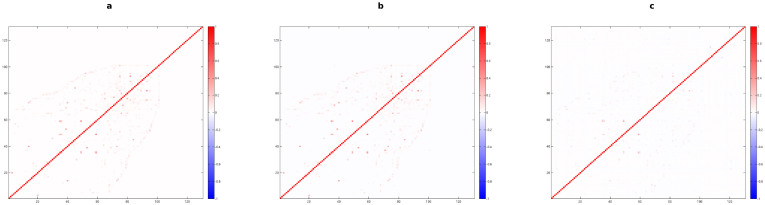
Analysis of the binary multiplexity between layers of the European Airport Network.Color-coded matrices with entries given by mbin (a), μRG (b) and μBCM (c) for any pair of layers (airlines).